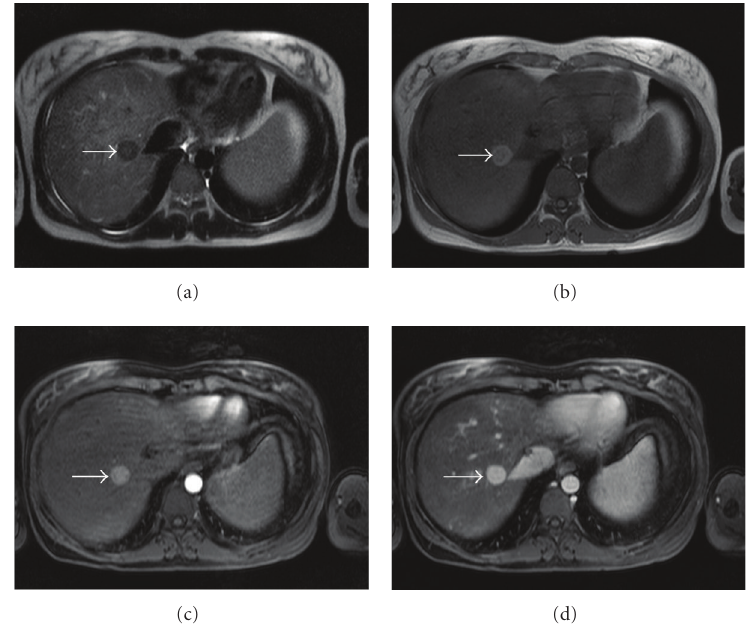
Figure 1: In T2-weighted HASTE sequence, (a) the reference lesion reveals hypointense (arrow). In precontrast T1-weighted FLASH 2D sequence, it is inhomogeneous hyperintense (arrow) (b). Arterial phase (c) and portal venous phase (d) T1-weighted VIBE show a progredient enhancement